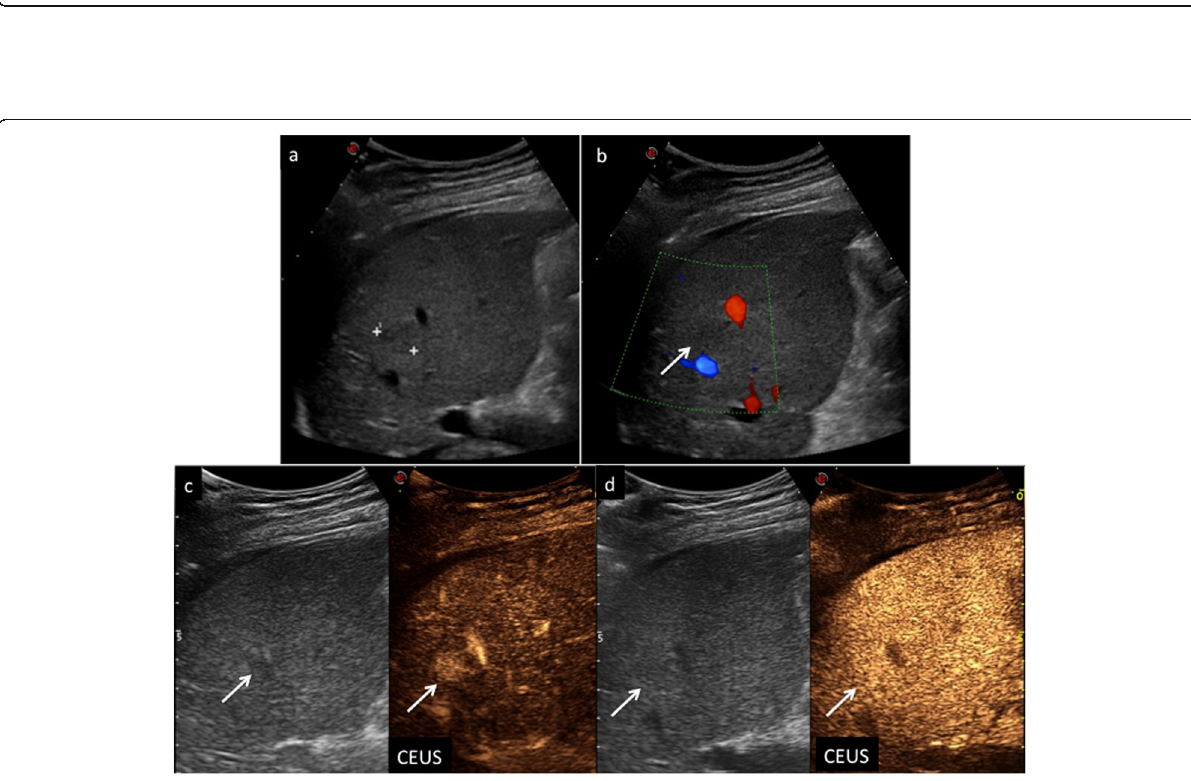
Fig. 8 CEUS LI-RADS 4 (probably HCC). Nodule in a 52-year-old woman with virus C-related cirrhosis. Baseline US image ( a ) shows a slightly hypoechoic lesion sized 1.5 cm in the segment VIII (calipers). No vascular signal is detectable at color-Doppler ( b ) (arrow). At CEUS, the nodule is highly hypervascular during the arterial phase ( c ) (arrow) and isoechoic in the extended portal venous phase ( d ) (arrow)